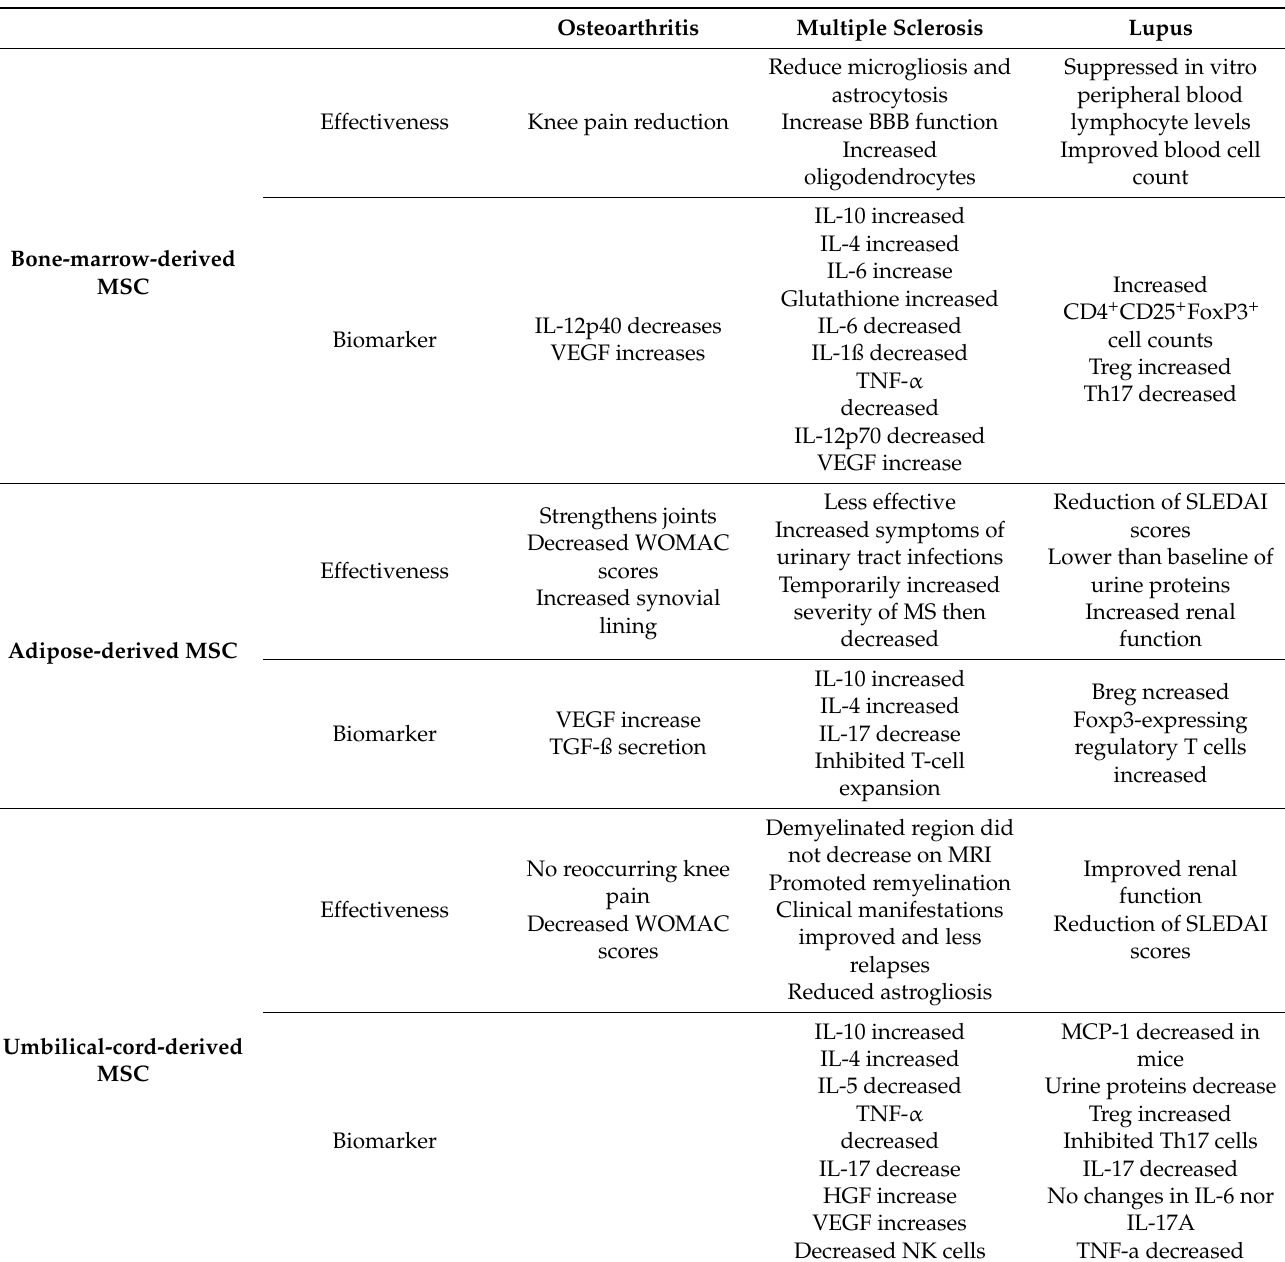
Table 1. Summary of the effectiveness and biomarkers found by utilizing bone marrow (BM-MSC), adipose (AD-MSC), and umbilical-cord (UMC-MSC)-derived MSCs in osteoarthritis, multiple sclero- sis, and systemic lupus